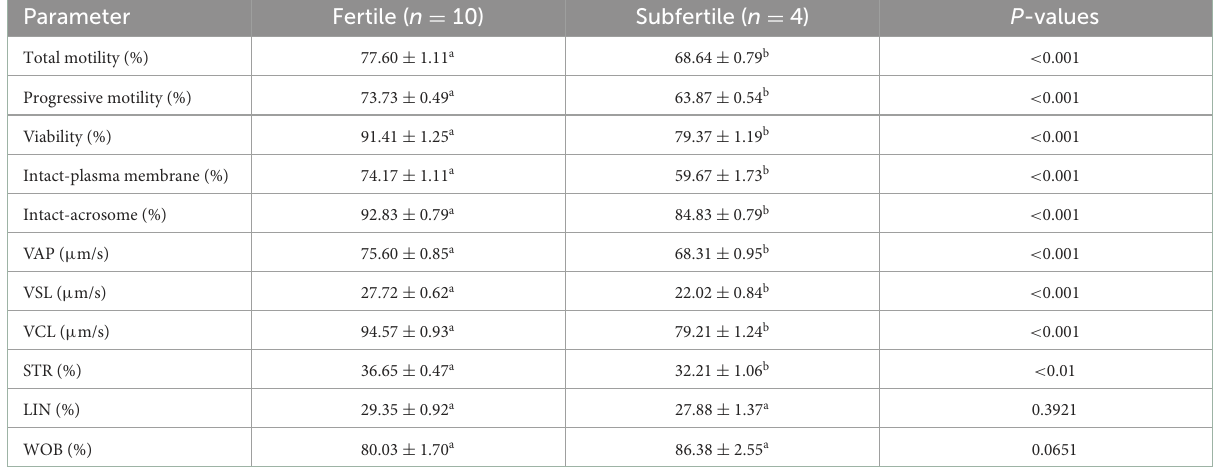
TABLE 1 Sperm characteristics and kinematics (mean ± SEM) of fertile and subfertile buffalo bulls. Parameter